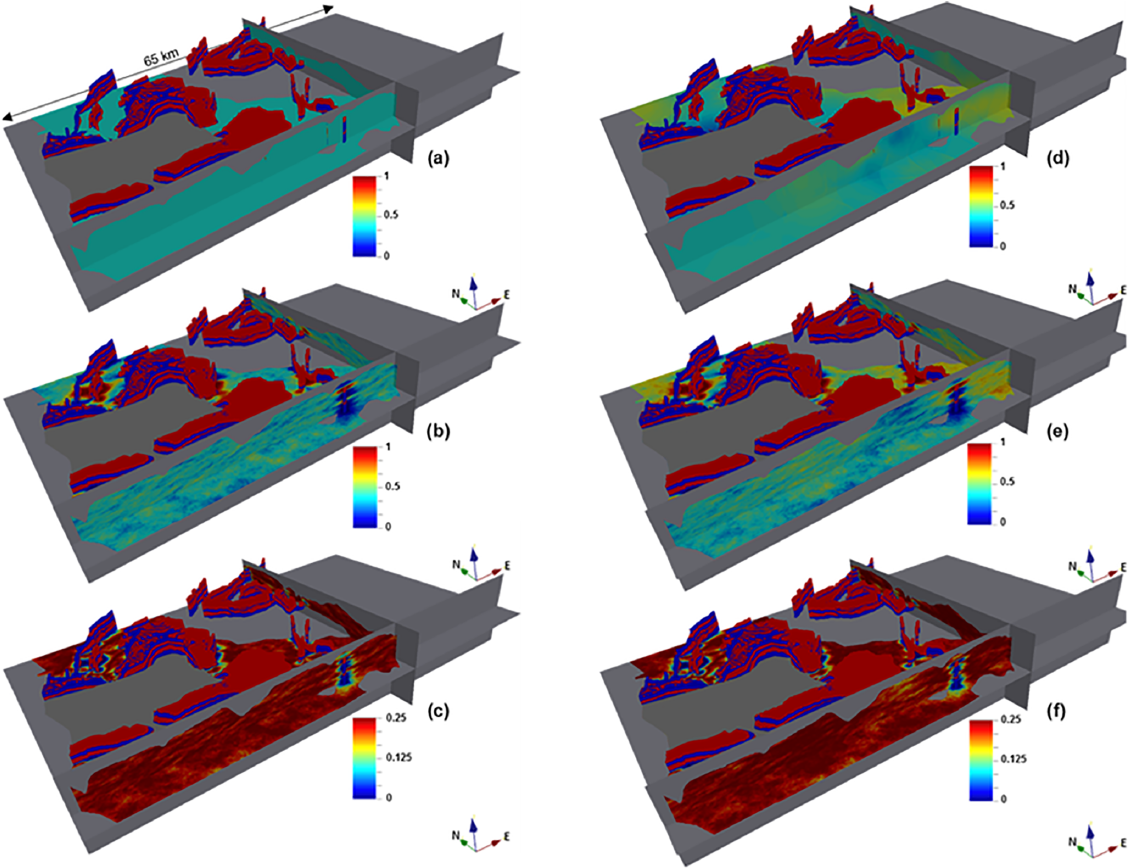
Figure A4. Comparison of the conditioning strategies c and d of Table 1 in terms of (i) soft and hard conditioning – shown in panels (a, d) ; (ii) e-type map – shown in panels (b, e) ; (iii) variance map – shown in panels (c, f) . To facilitate the comparison, the probabilities in panels (a, d) are presented in a different colour scale with respect to Figs. 8 and 9. The e-type and variance maps are based on 100 realizations. In all panels, the interpretation of the seismic data, and the buffer zone around the Tønder model are explicitly shown in terms of sand and clay (the red homogeneous volumes represent the sand bodies, the blue volumes show the clay lenses). Vertical exaggeration = 20 ×